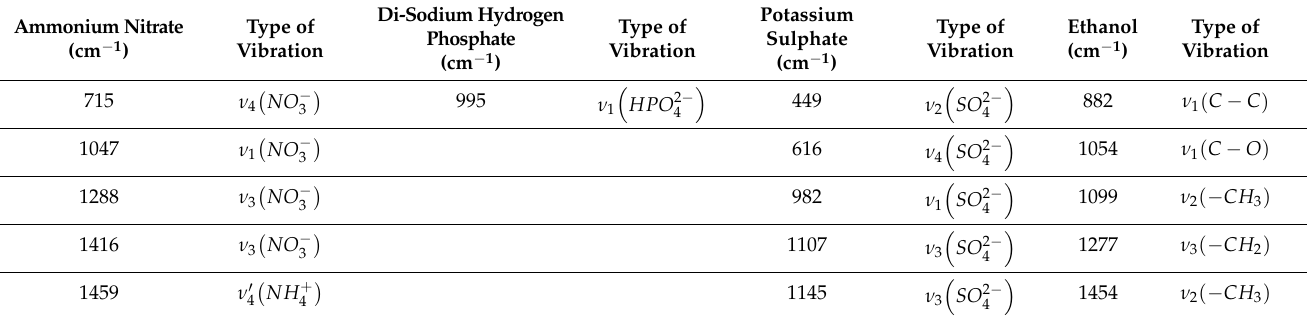
Table 1. Raman band assignment of the individual substances below a Raman shift of 1500 cm − 1 .